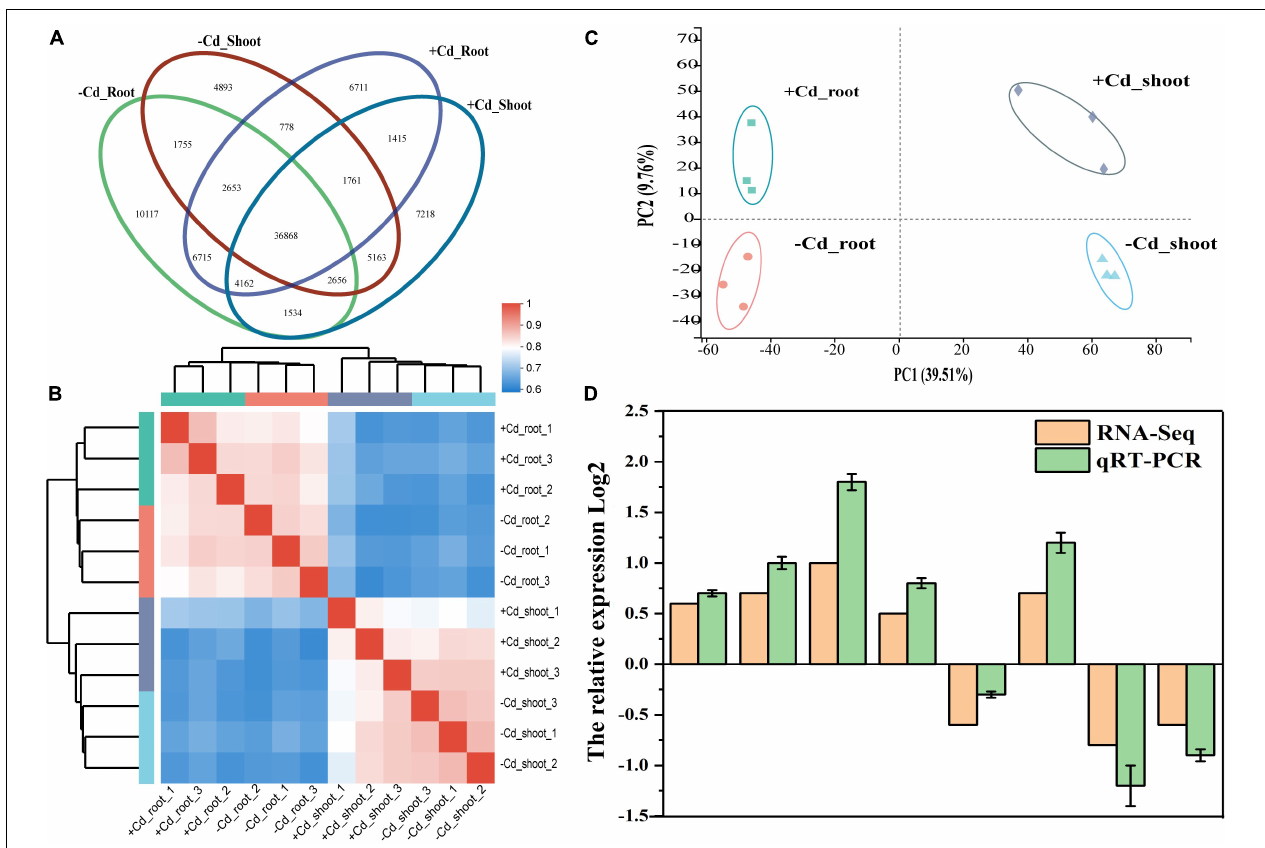
FIGURE 3 | Venn diagram (A) , heatmap tree of groups (B) , principal component analysis (PCA) (C) , and quantitative real-time PCR (qRT-PCR) validation (D) of plant